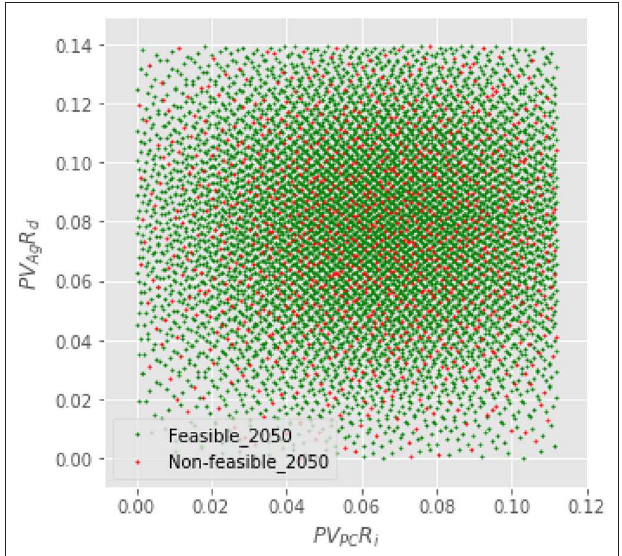
FIGURE 11 | Feasible (green) and non-feasible (red) scenarios in the year 2050. The coordinates of each points are the values of the parameters (PV PC R i , PV Ag R d ) used in a given simulation. Monte Carlo simulations run on 8,192 quasi-random